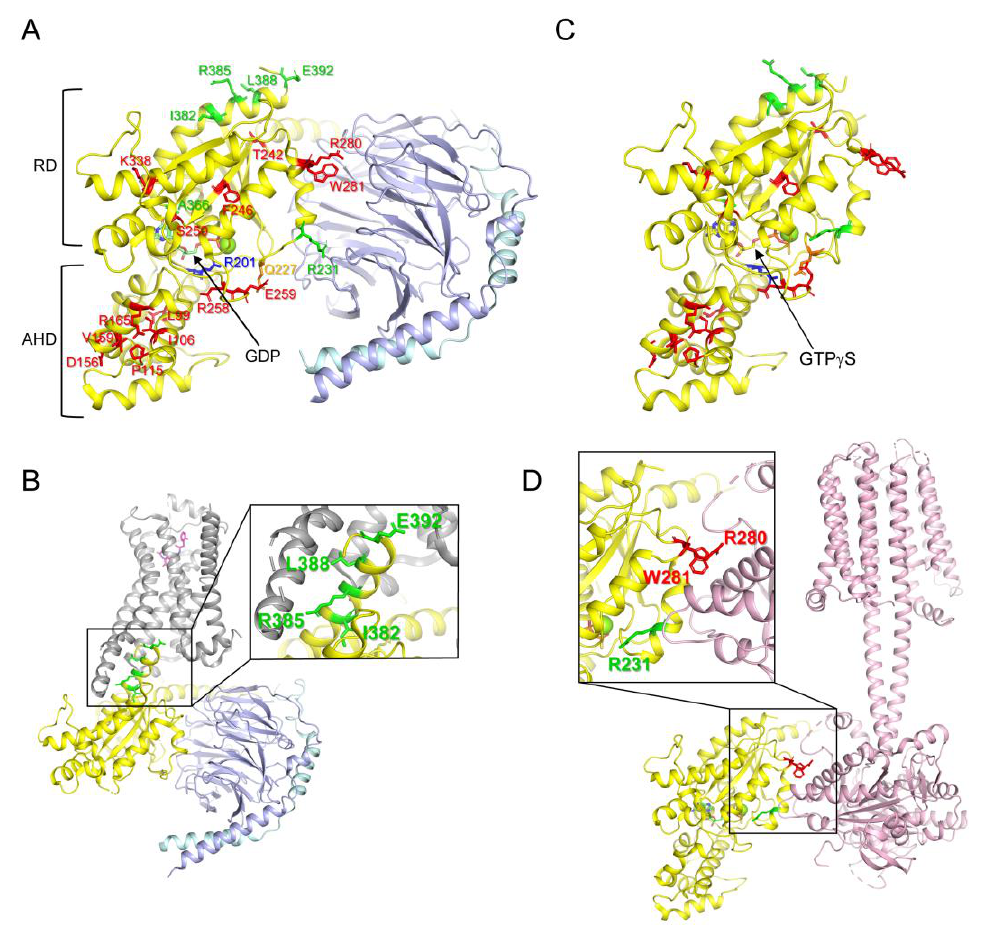
Figure 1. Structure of G proteins and mutated residues of the natural variants. ( A ) Structure of GDP- bound Gs (PDB: 6EG8) and reported mutated residues in the Gαs natural variants. Gαs, Gβ, and Gγ are colored yellow, light blue, and cyan, respectively. Mutated residues in the Gαs natural variants are shown as sticks. Red sticks present the residues analyzed in the current study; Green sticks pre- sent the residues whose molecular mechanism is well-understood; blue and orange residues are mutated in the gain-of-function natural variants. RD represents the Ras-like GTPase domain, and AHD represents the α -helical domain. ( B ) Structure of β 2 AR- Gs complex (PDB: 3SN6). Gαs, Gβ, Gγ, and β 2 AR are colored yellow, light blue, cyan, and grey, respectively. Mutated residues at the re- ceptor-binding interface are shown as green sticks. ( C ) Structure of GTPγS - bound Gαs (PDB: 1AZT). Mutated residues in the Gαs natural variants are shown as sticks as described in ( A ). ( D ) Structure of the adenylyl cyclase- bound Gαs (PDB: 7PDE). Gαs and adenylyl cyclase 9 are colore d yellow and light pink, respectively. Mutated residues at the adenylyl cyclase-binding interface are shown as green and red sticks.